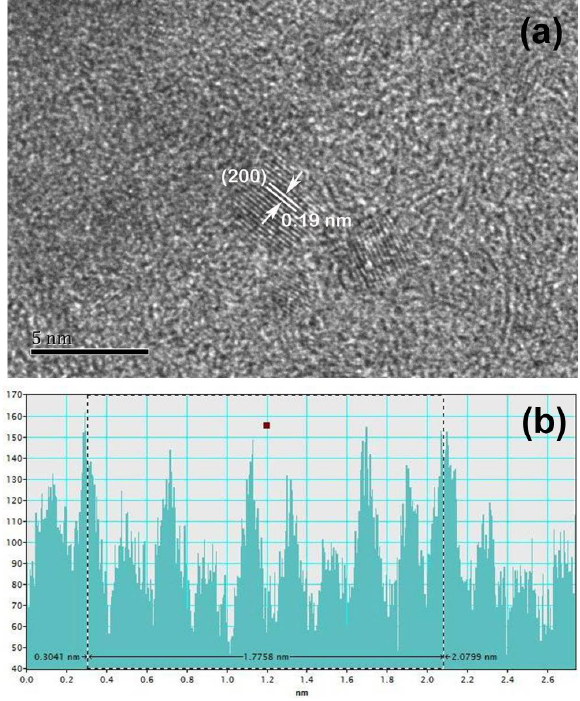
Figure 4: (a) HRTEM image of Pt nanoparticles; (b) Intensity profile created by Digital Micrograph on the marked Pt nanoparticle in the HRTEM